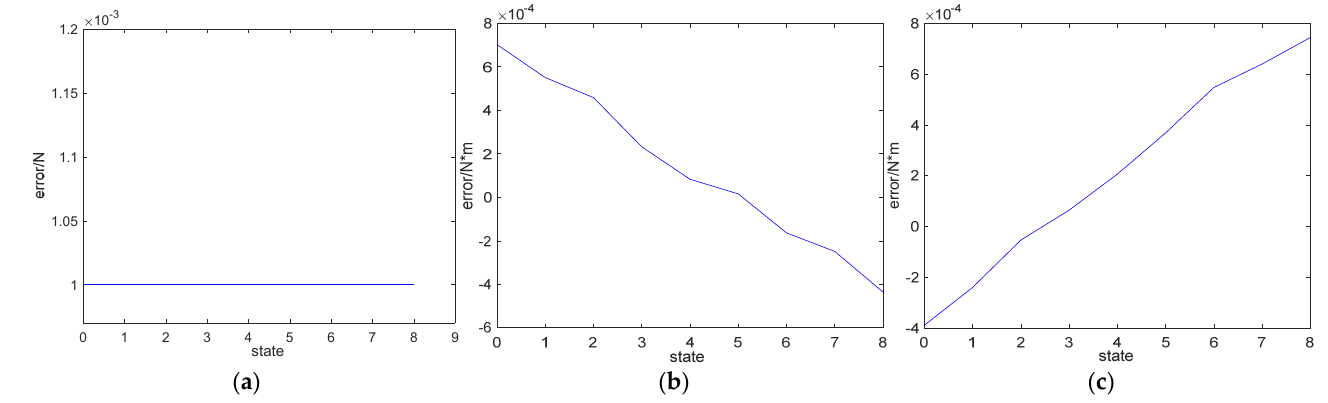
Figure 14. Error of simulation 2. ( a ) Upper kinematic chain. ( b ) Bottom kinematic chain 1. ( c ) Bottom kinematic chain 2.